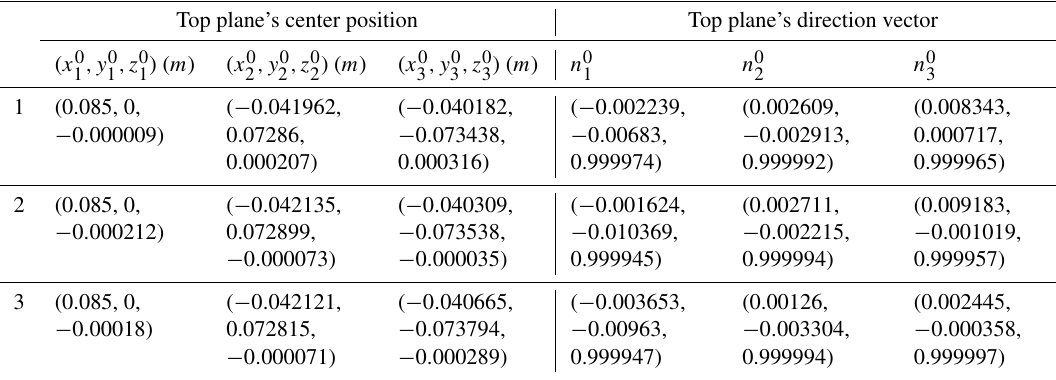
Table 5. Position and orientation of the top planes.